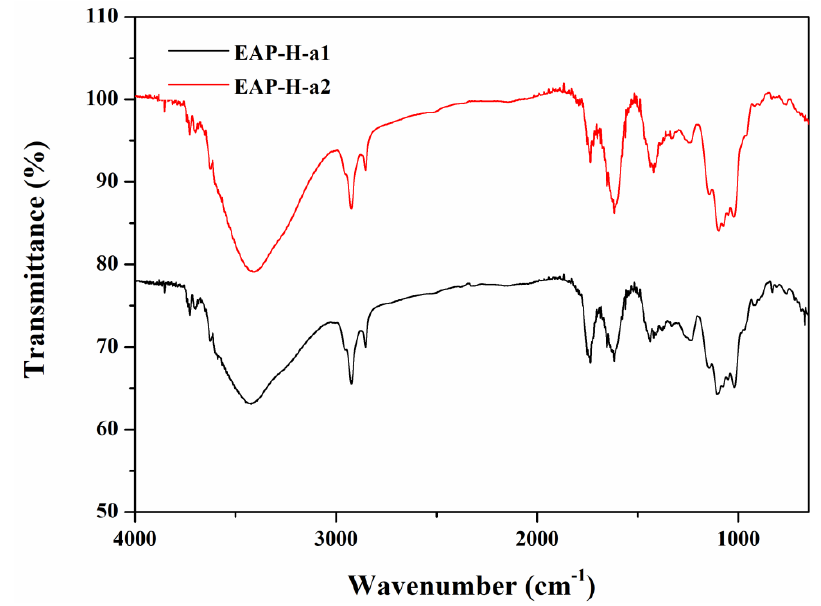
Figure 3. IR spectrum of the polysaccharides.